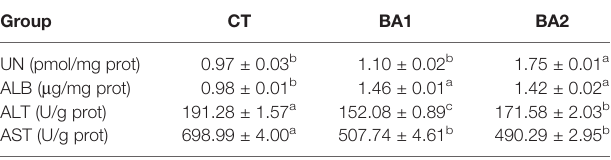
TABLE 4 | Effects of dietary bile acids on hepatic function indices of tongue sole.